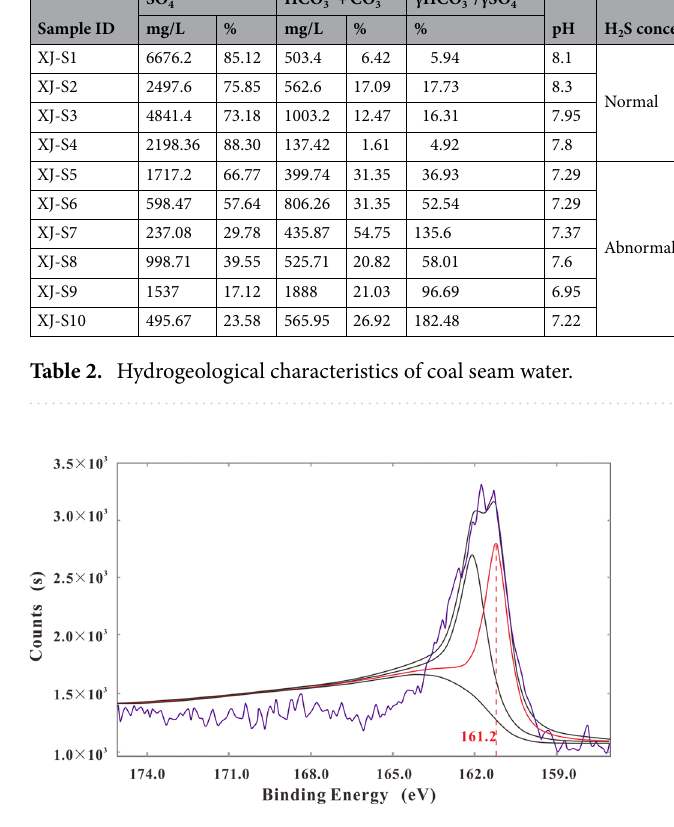
Figure 2. The peak spectrum of S of the black solid in the culture bottle with sample